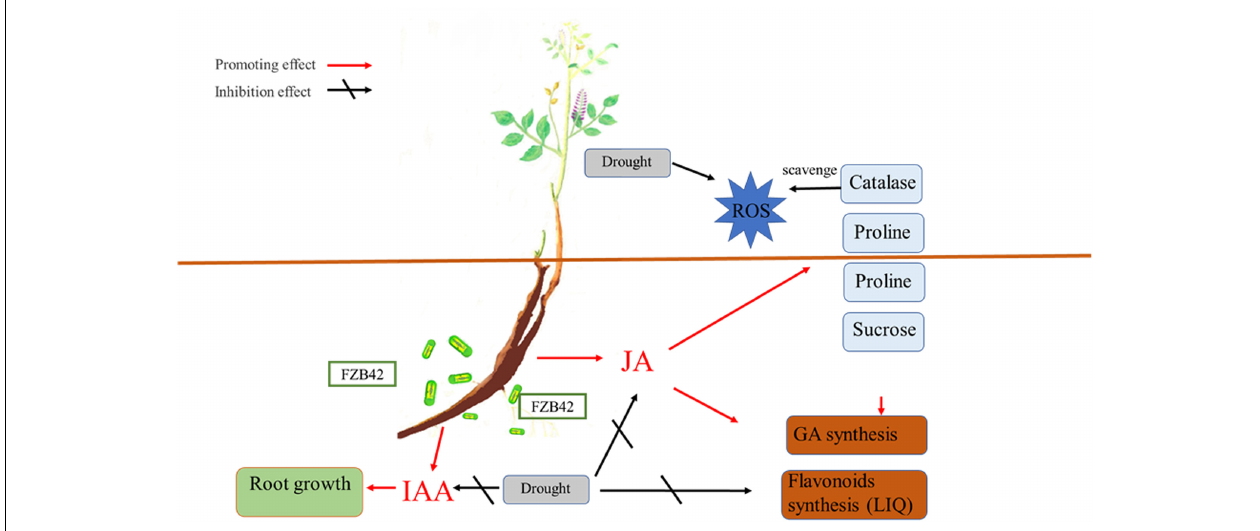
FIGURE 7 | Postulated mechanism by which the Bacillus amyloliquefaciens FZB42 strain induces drought tolerance and rescues glycyrrhizic acid (GA) loss in drought-stressed Glycyrrhiza uralensis plants via the JA pathway’s activation. IAA, indoleacetic acid; JA, jasmonic acid; ROS, reactive oxygen